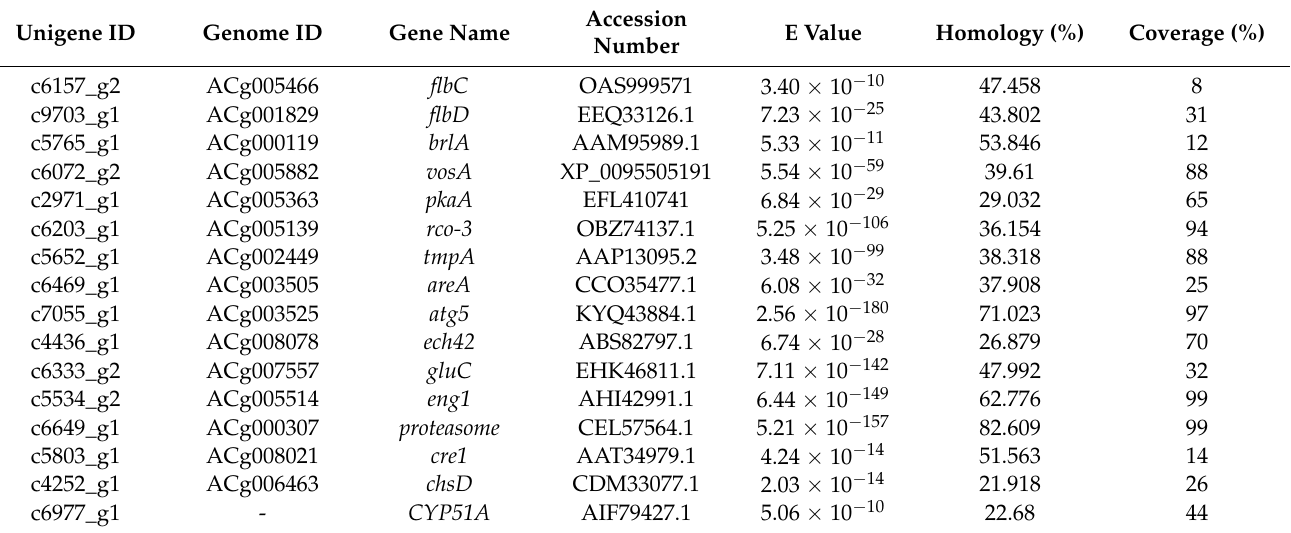
Table 4. Differential expression genes with possible involvement in the condition of A. cinnamomea